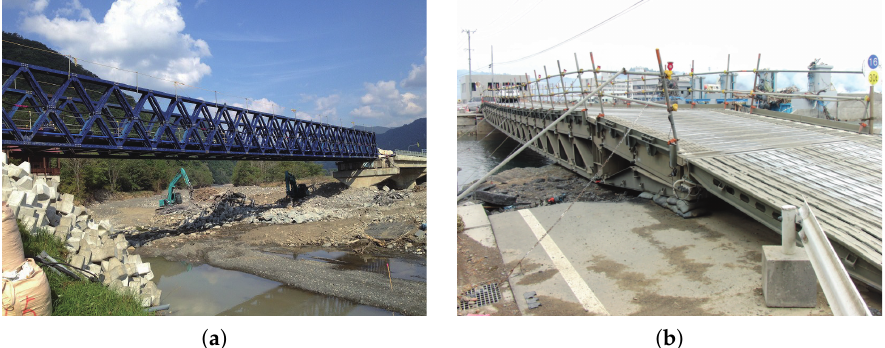
Figure 1. Collapsed bridges due to flooding in Kumamoto, Japan (July 2020).